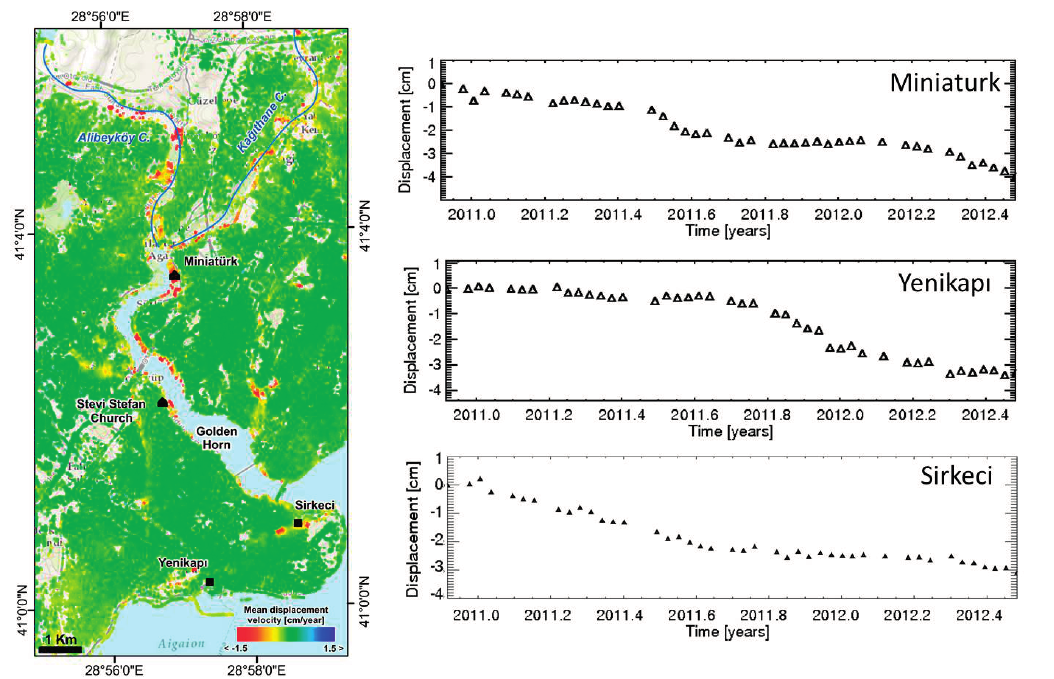
Figure 5. Left : zoomed view of the low-resolution SBAS-DInSAR deformation velocity map, related to the Golden Horn area (for location see Figure 4). Right : time-series of displacements for three unstable SAR measure points located in the artificially filled area of Miniaturk and in the new Marmaray stations of Yenikap ı and Sirkeci.